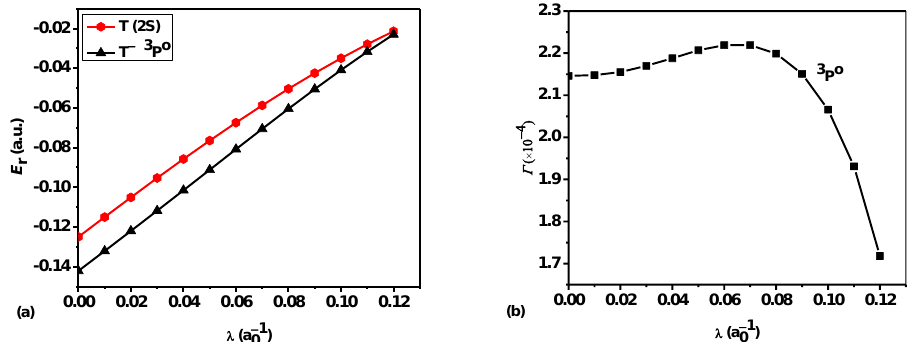
Figure 15. ( a ) Plot of the lowest 3 P o resonance energy 𝐸 𝑟 of T − vs. 𝜆 . ( b ) Plot of the corresponding resonance width 𝛤 of T − vs. 𝜆 .